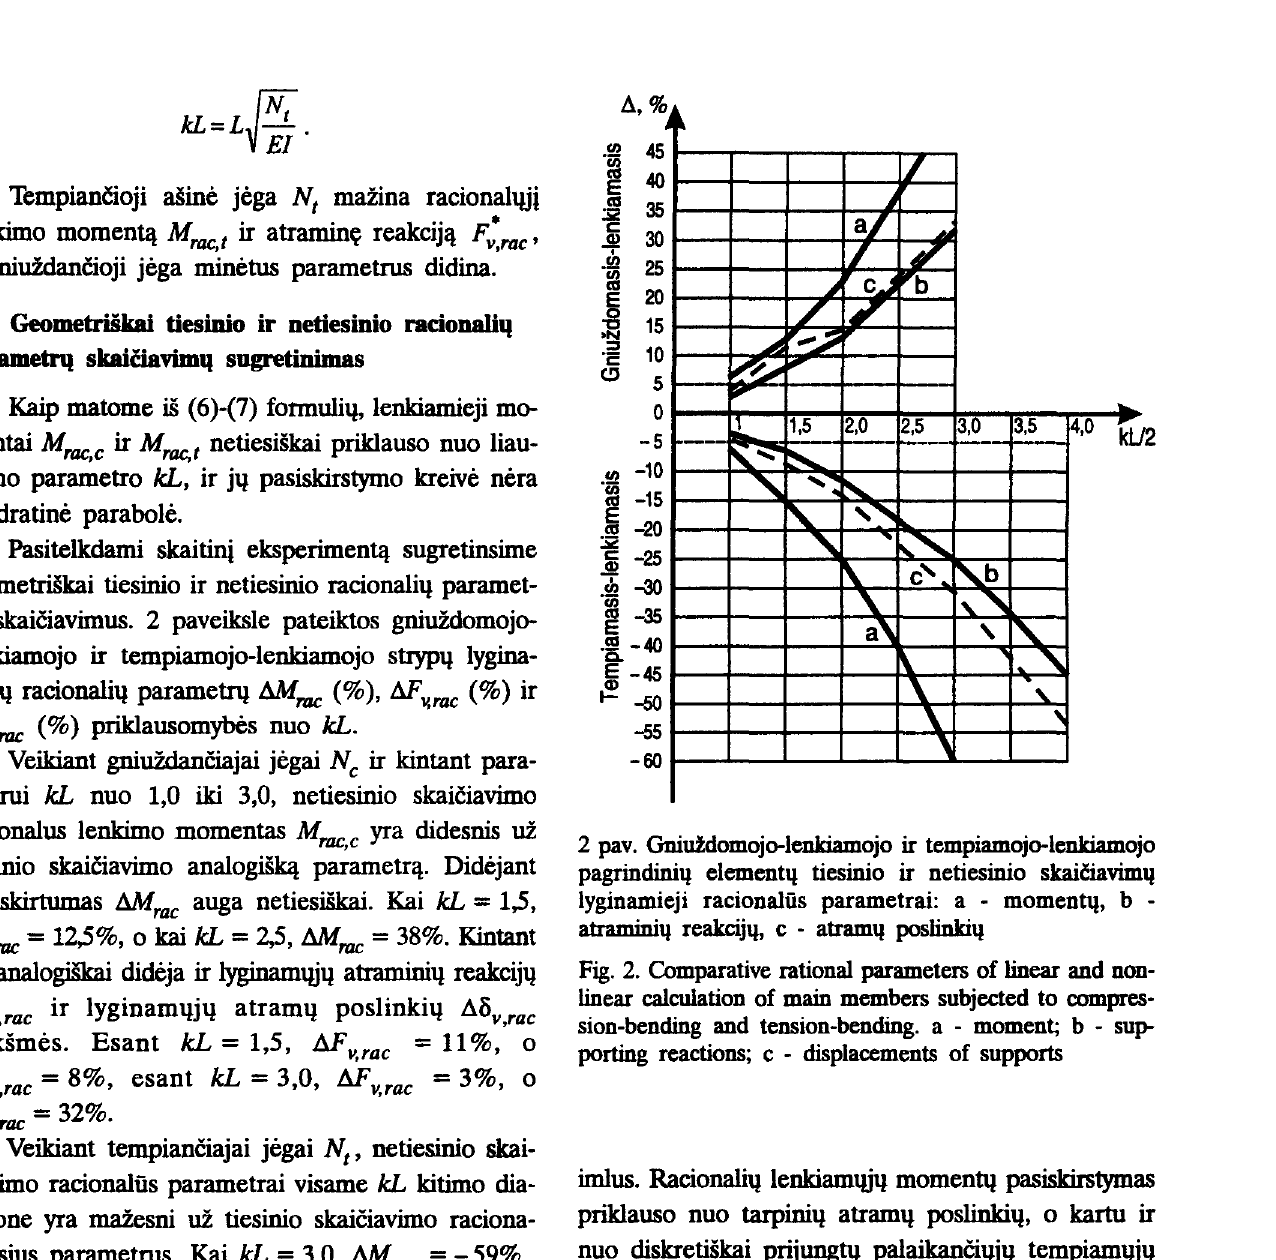
imlus. Racionaliq lenkiamqjq momeDtq pasiskirstymas